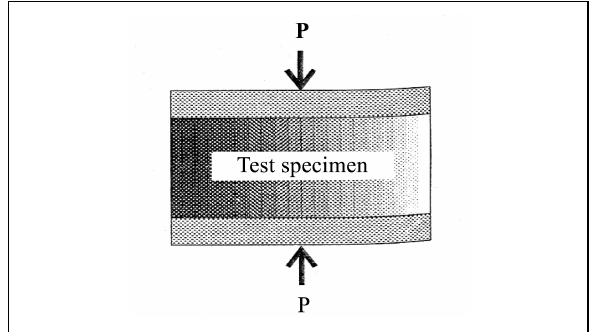
Fig 3. Specimen setup for permanent compressive strain test